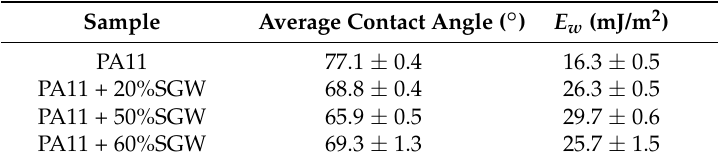
Table 2. Average water contact angles and wetting Energy ( E w ) for PA11 and PA11